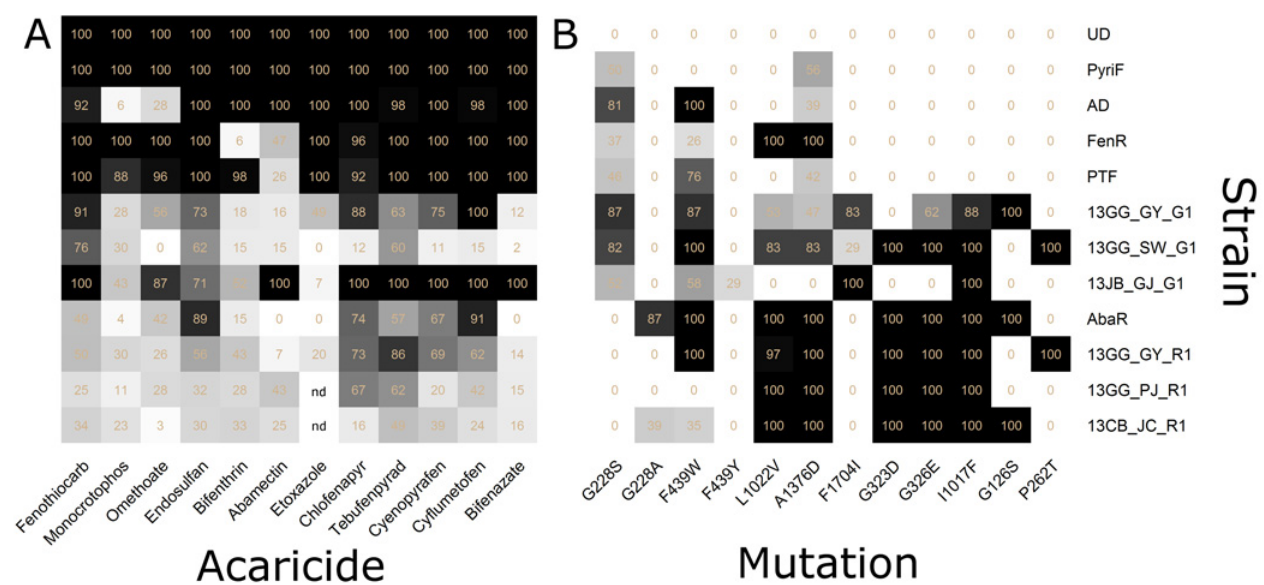
Fig 2. Heat maps of the mortalities and allele frequencies in 12 strains of T . urticae . (A) Heat map of the mortalities obtained by the diagnostic doses of RCV. (B) Heat map of the allele frequencies of 12 target site mutations determined by QS. The figure in each cell represents the actual value of color intensity and ‘ nd ’ in the empty cells represents a ‘ not-determined value ’ . The actual values calculated by regression equation were listed in S6 Table.